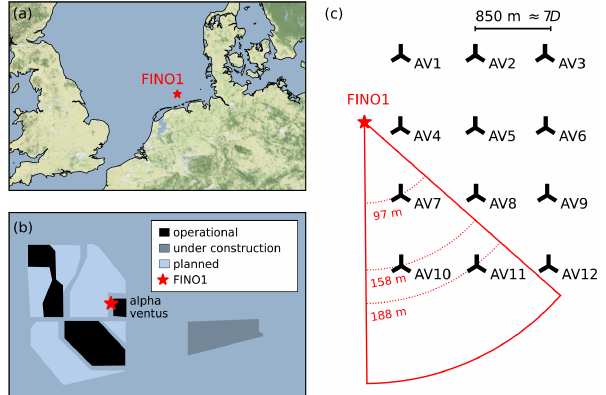
Figure 1. A schematic shows the (a) location of FINO1 platform, map made with Natural Earth; (b) wind farms and platforms near FINO1, status in 2015–2016; and (c) alpha ventus wind farm layout, with maximum lidar scan area and scanning height at the position of each wind